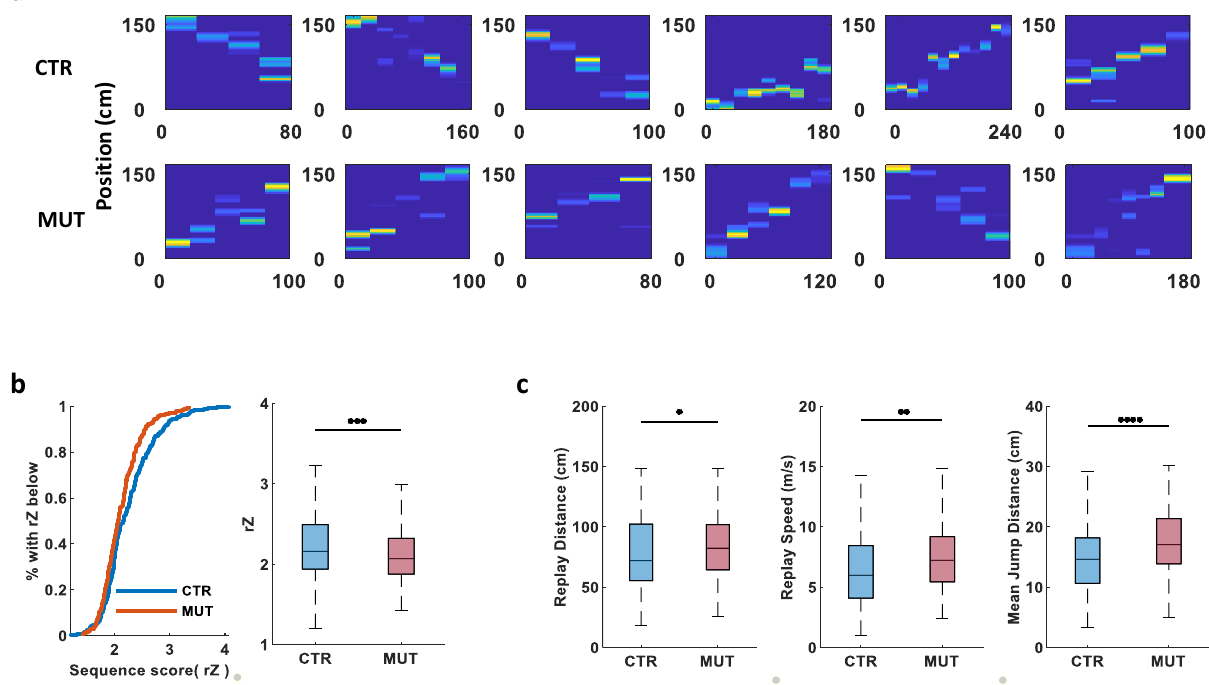
Fig. 4 Silencing CA3 input alters the replay sequences in bilateral CA1. a Examples of trajectory sequences derived from Bayesian decoding of spiking activity from bilateral CA1 during SWRs periods. Top: controls; bottom: mutants. Colors are scaled to posterior probability of each signi fi cant decoded replay event in 20 ms time bins (blue, minimum; yellow, maximum). b The quality of signi fi cant replay events decoded with cells from bilateral CA1 during SWRs detected in either hemispheres was reduced in mutant mice (left: population distribution, right: box plot; CTR: N = 4 animals, n (right ripple) = 166 events, n (left ripple) = 111 events, n (combined) = 277 events; MUT: N = 5 animals, n (right ripple) = 103 events, n (left ripple) = 79 events, n (combined) = 182 events; P (rZ) = 0.0037). c The distance, speed, and mean jump distance between adjacent positions of signi fi cant replay events decoded with cells from bilateral CA1 during SWRs detected in either hemispheres was higher in mutant mice (CTR: N = 4 animals, n (right ripple) = 166 events, n (left ripple) = 111 events, n (combined) = 277 events; MUT: N = 5 animals, n (right ripple) = 103 events, n (left ripple) = 79 events, n (combined) = 182 events; P (replay speed) = 0.0012, P (replay distance) = 0.0408, P (mean jump distance) = 1.1602 × 10 − 5 ). All signi fi cant difference in Fig. 4 were tested with two-sided Wilcoxon ’ s rank-sum